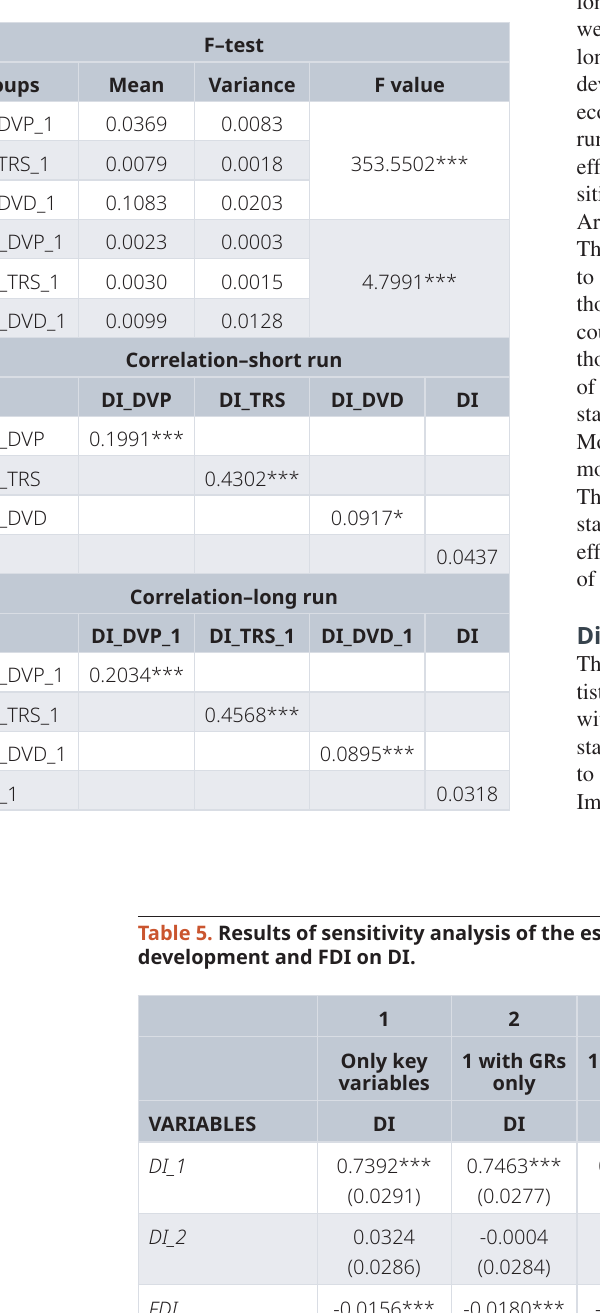
Table 4. F test and pairwise